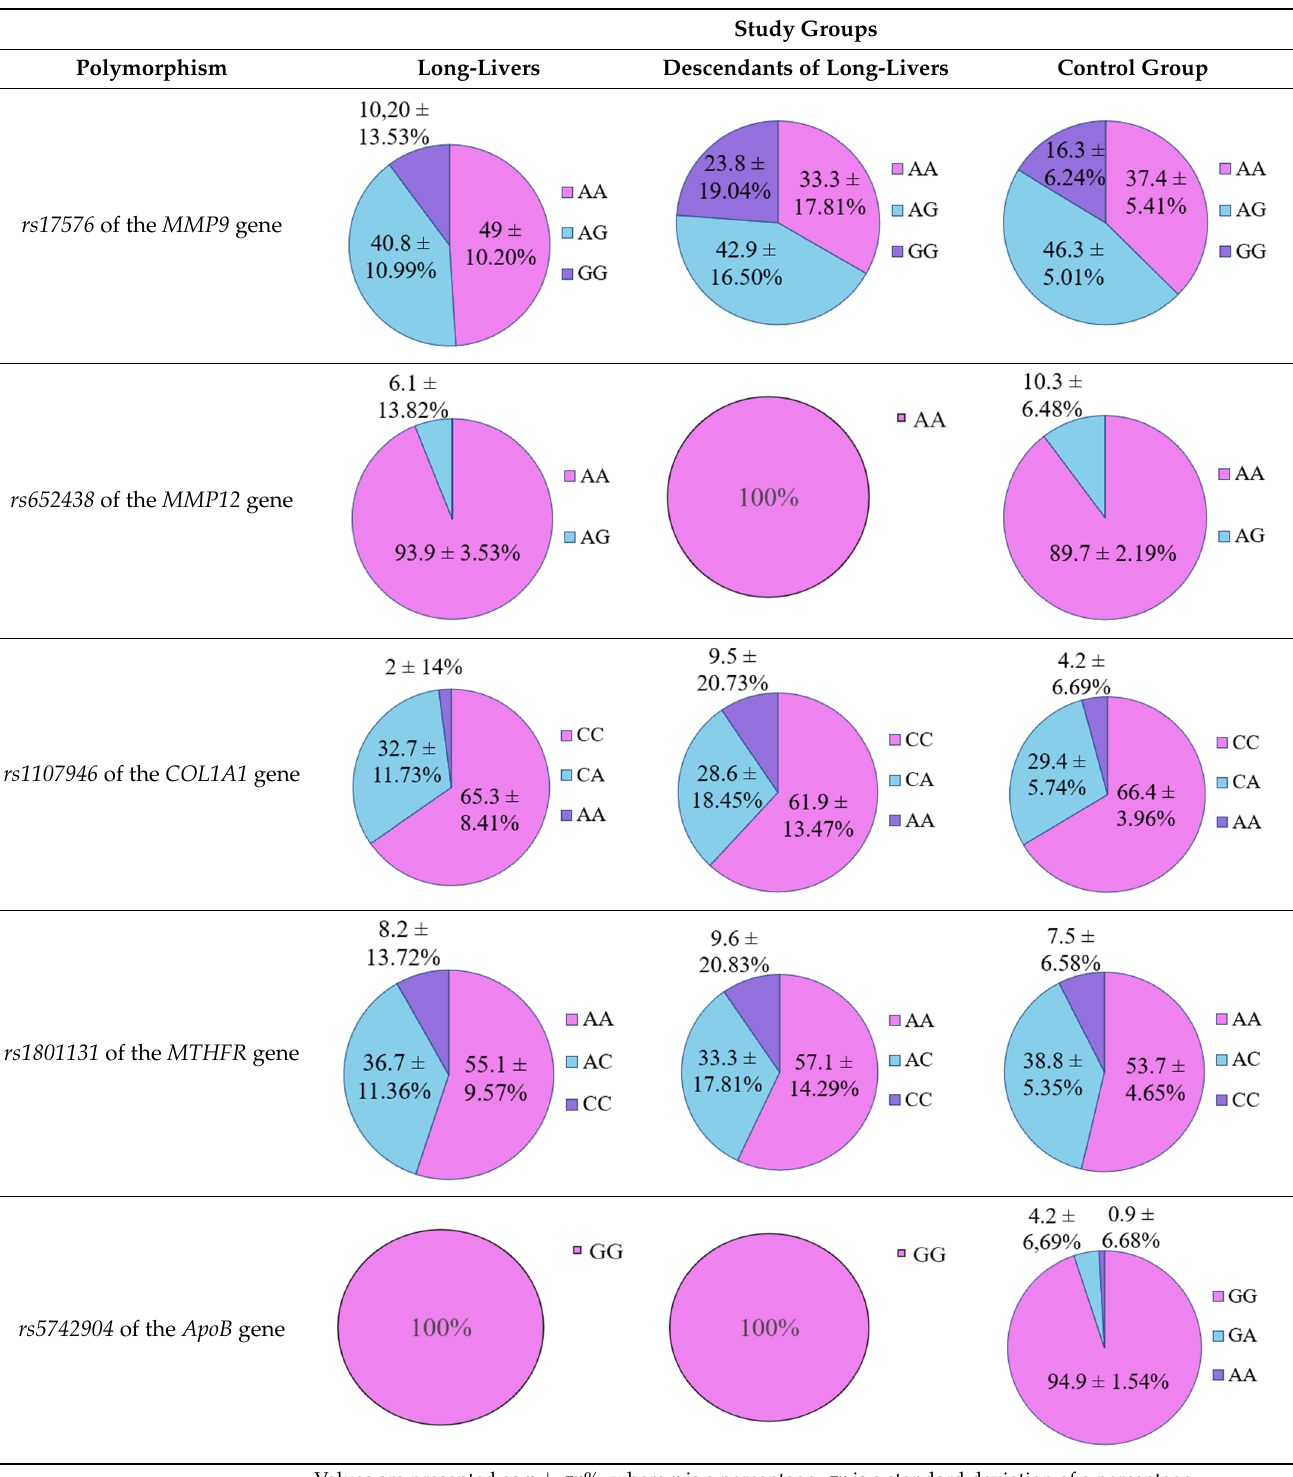
Table 2. Distribution frequency of MMP9 , MMP12 , COL1A1 , MTHFR , ApoB gene polymorphisms among the three studied groups.